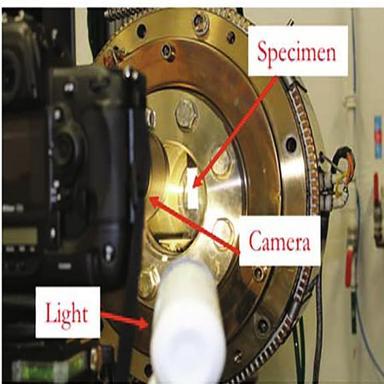
Picture of the acquisition system setup.